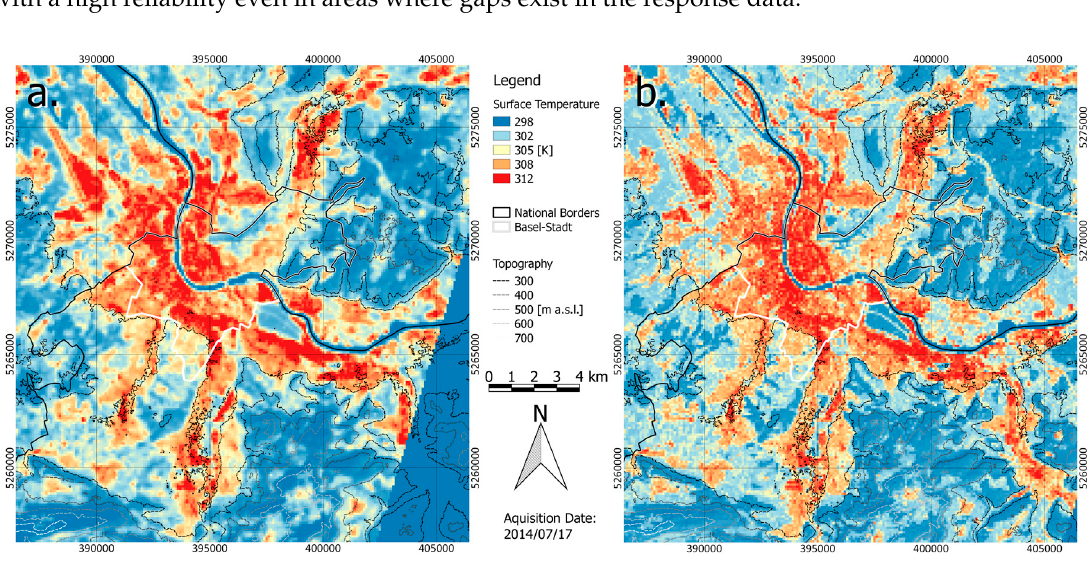
Figure 8. Original L8 TIRS LST resampled to 100-m resolution ( a ) and predicted image from the coefficients of the MLR ( b ) from 17 July 2014 ( R 2 = 0.87). The dashed grayscale lines describe the topography and the black and white lines national and cantonal borders; the coordinate system is UTM-32N.